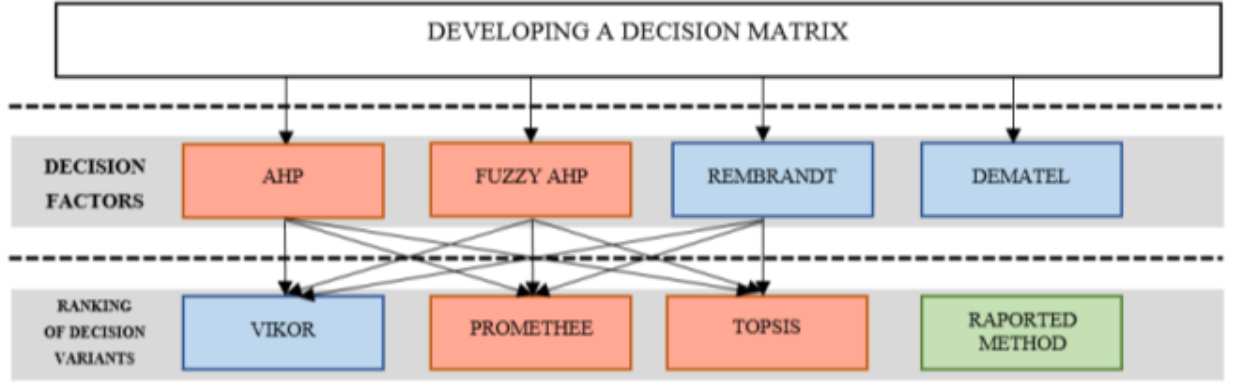
Figure 2. The basis for the proposed hybrid approach. Source: author’s work.